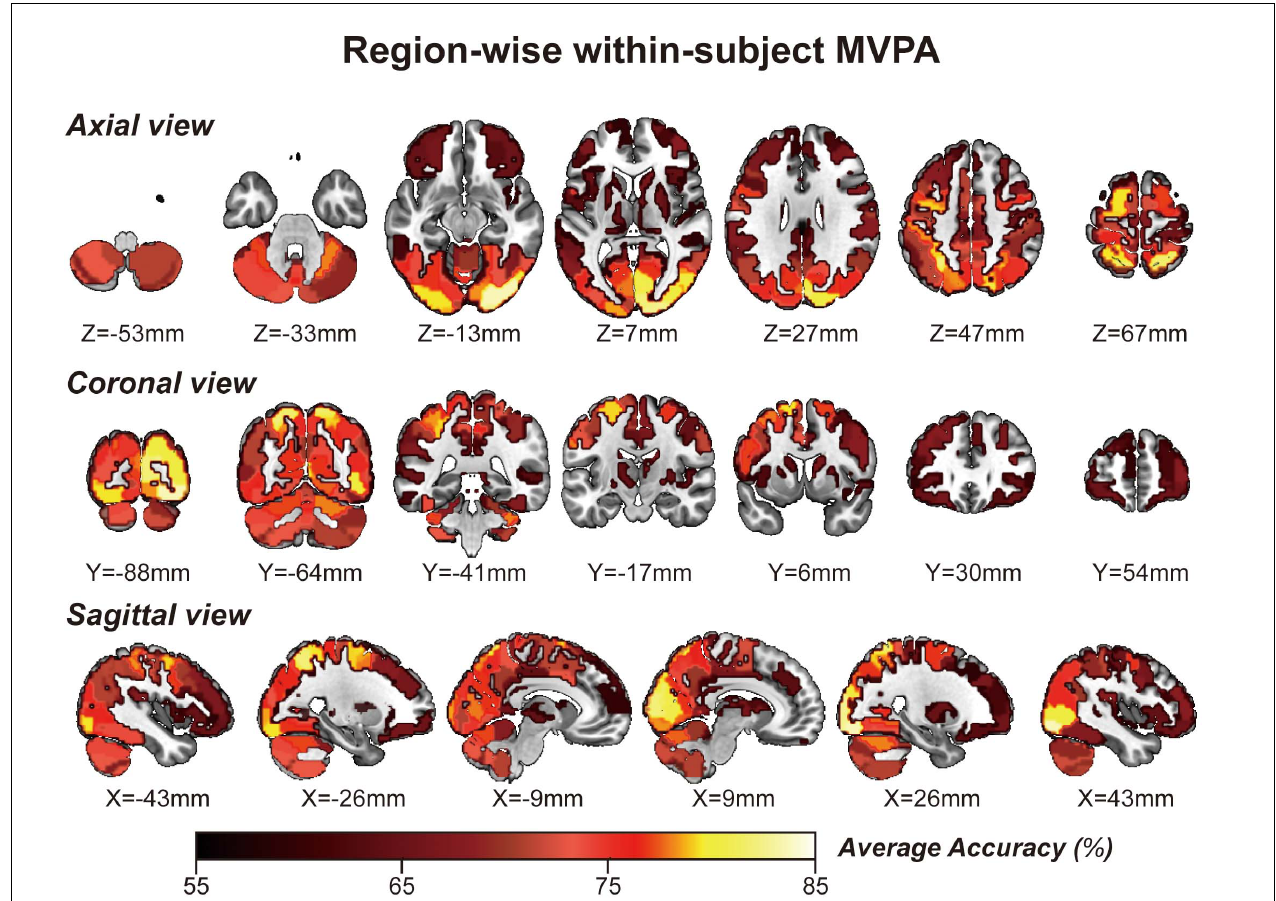
FIGURE 5 | Whole-brain regionwise between-subject MVPA result obtained from “navigational vs. non-navigational” state classification. The hot bar at the bottom indicates percentage accuracy values. Numbers represent X (sagittal view), Y (coronal view), and Z (axial view) coordinates in the MNI